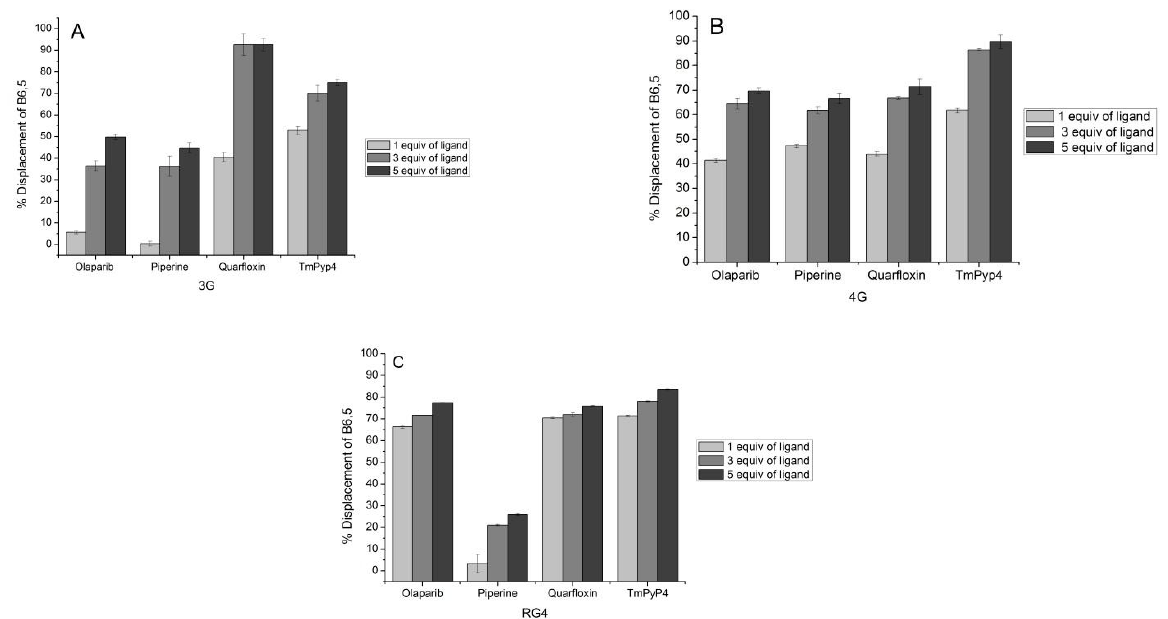
Figure 4. Affinity of ligands olaparib, piperine, quarfloxin, and TmPyP4 analyzed using B6,5 displacement assay in DNA G-quadruplexes ( A ) 3G and ( B ) 4G and also in ( C ) RNA G-quadruplex.